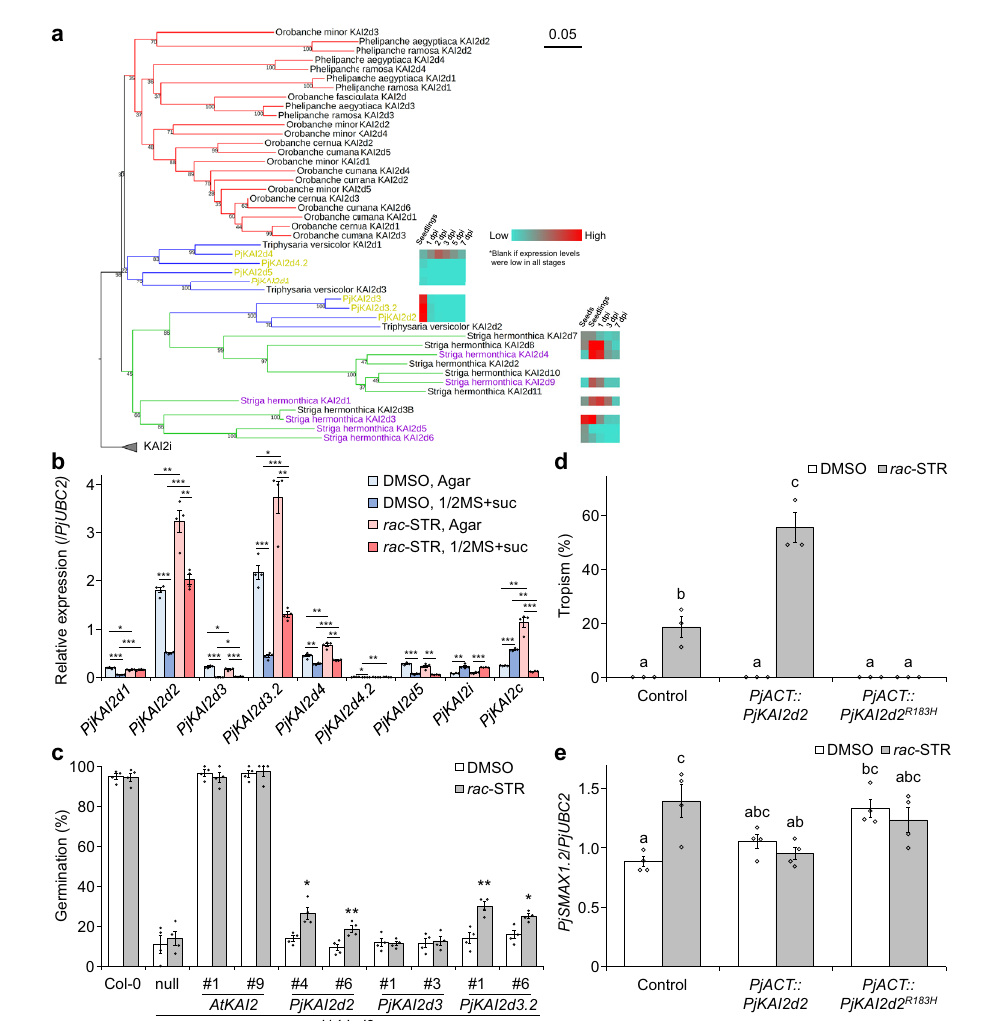
Fig. 4 | Analyses of KAI2 homologues in P. japonicum . a KAI2d phylogeny. The KAI2i clade was included asan outgroup. Clades are coloured blue, green, and red for facultative hemiparasites, obligate hemiparasite, and obligate holoparasites, respectively. Purple and yellow words indicate KAI2d forms in S. hermonthica that recognise SLs 30,77 and KAI2d forms in P. japonicum (PjKAI2d), respectively. Colouredboxesindicategeneexpressionlevelsinrootsof P.japonicum for PjKAI2d orinseeds,seedlings,orrice-infectingplantsat1-,3-,7-daypostinfection(dpi) 18,29 . Thebarindicatessubstitutionspersite.Bootstrapvaluesareindicatedatthenodes. b Relative expression levels of PjKAI2 genes. Representative data are shown (four technicalreplicates)using PjUBC2 asthereferencegene. c Complementationassays for PjKAI2d. Arabidopsis kai2 d14 (Col-0 ecotype) was used for the null mutant to express PjKAI2d under control of the AtKAI2 promoter. Germination rates were calculated 5 days after incubation at 22°C in the dark. Representative data